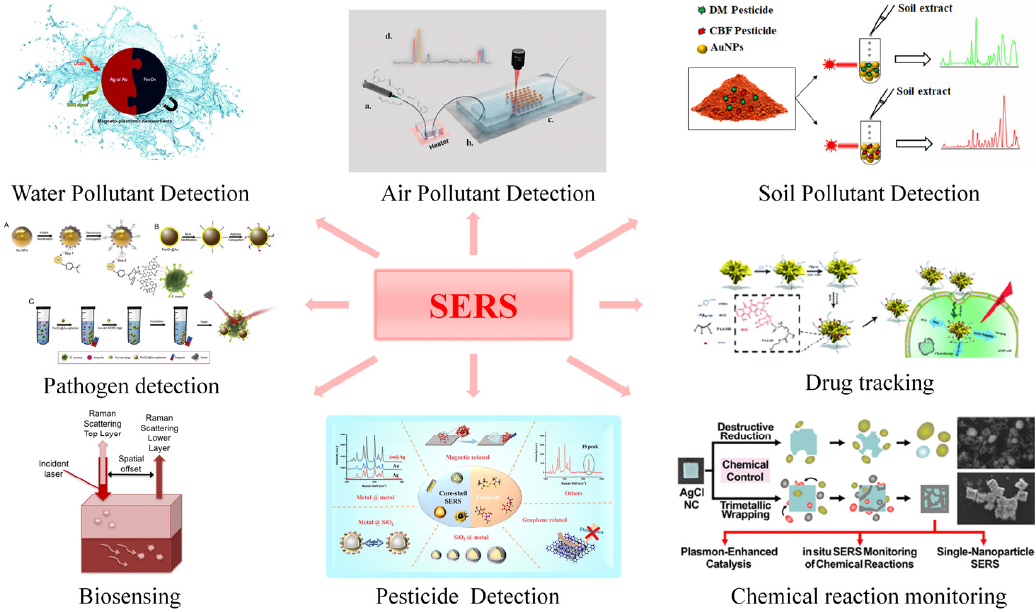
Figure 2. Surface-enhanced Raman scattering has a wide range of applications in many sensing fields, such as water, air (adapted with permission from [42]. Copyright {2020} American Chemical Society), and soil pollutant detection; biosensing; drug tracking; pathogen detection; and chemical reaction monitoring (adapted with permission from [37]. Copyright {2020} American Chemical Society).